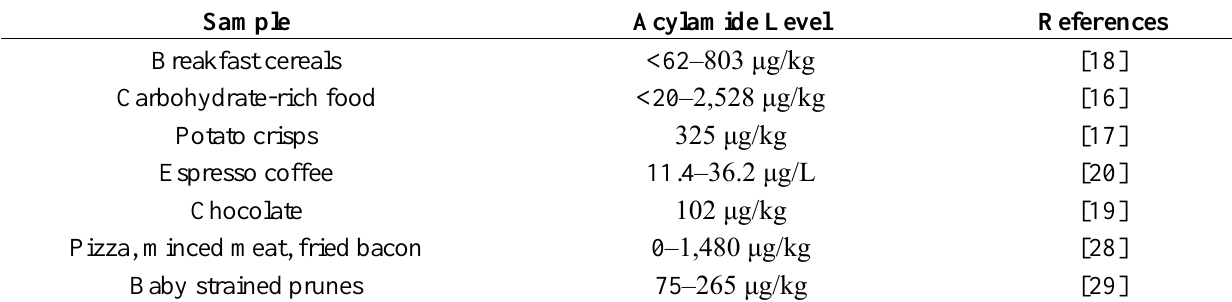
Table 3. The distribution and contents of acrylamide in